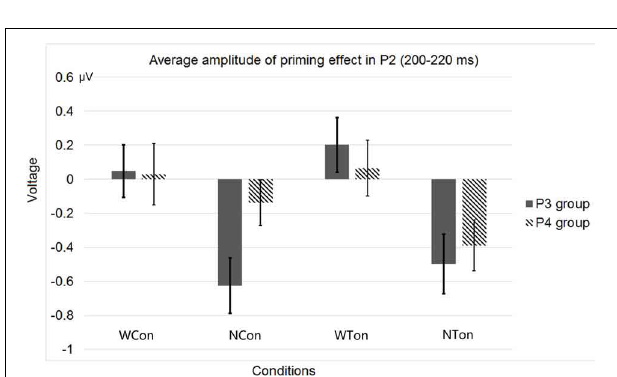
FIGURE 9 | Topographies of the contrasts of the late ERP component (500–550ms) in different conditions of Experiment 2. (A) Non-word vs. word experimental conditions; (B) Non-word vs. word control conditions.